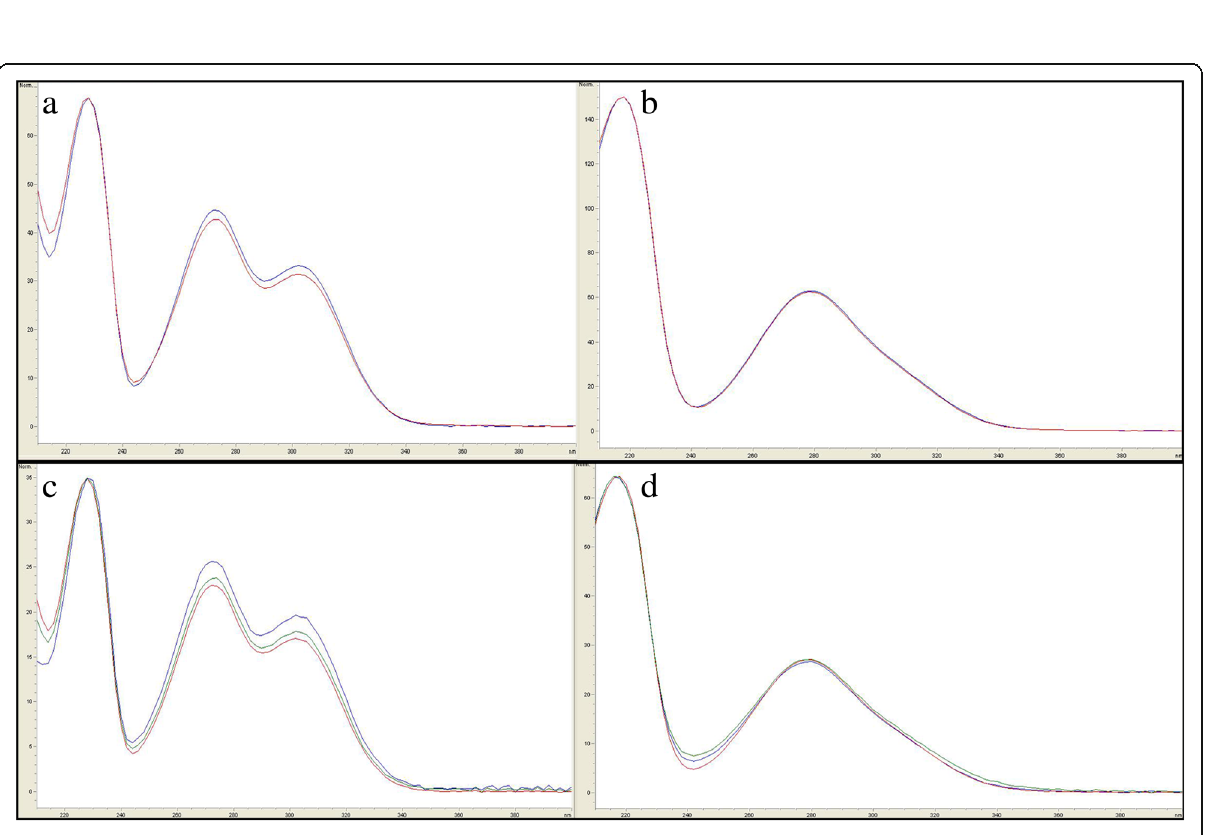
Fig. 5 Overlay UV spectra of compound 1 ( a ) and compound 2 ( b ) in crude extract solution (4mg/mL) compared with respective standards in standard solution (10 μ g/mL); overlay UV spectrum of each compound at peak start, peak apex and peak end: compound 1 ( c ) and compound 2 ( d